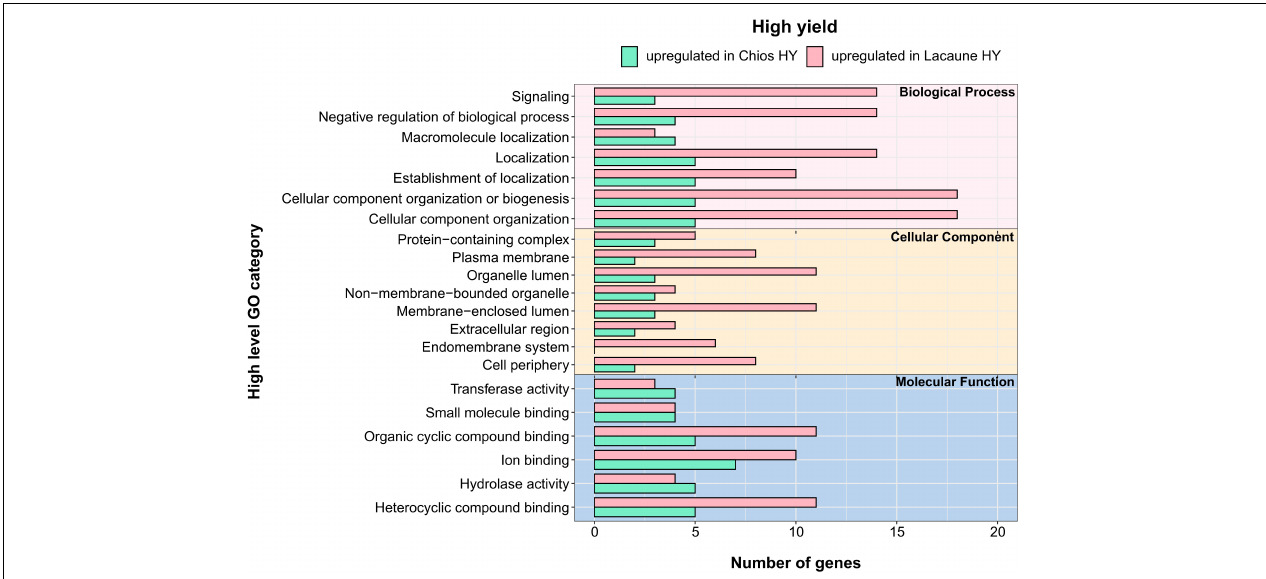
FIGURE 6 | Annotation of differentially expressed genes (DEGs) for the three categories in high yield groups: biological process, cellular component and molecular function. Y -axis illustrates functional categories after annotation of DEGs. X -axis indicates the total number of genes involved in each functional category. Green bars indicate terms that are upregulate in Chios high yielding animals (CH-HY) whereas pink bars indicate the terms that are upregulate in Lacaune high yielding animals (LA-HY).